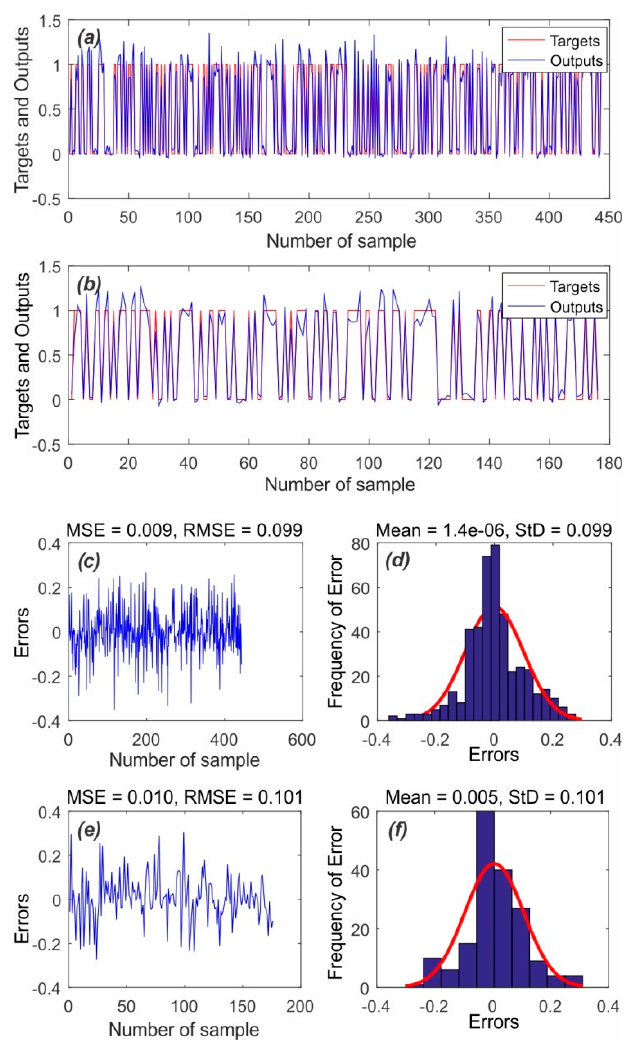
Figure 11. The SWARA-ANFIS-GWO method. ( a ) Target and outputs for the training set; ( b ) target and outputs for the verification set; ( c ) MSE and RMSE for the training set; ( d ) frequency errors for the verification set; ( e ) MSE and RMSE for the verification set; ( f ) frequency errors for the verification set.